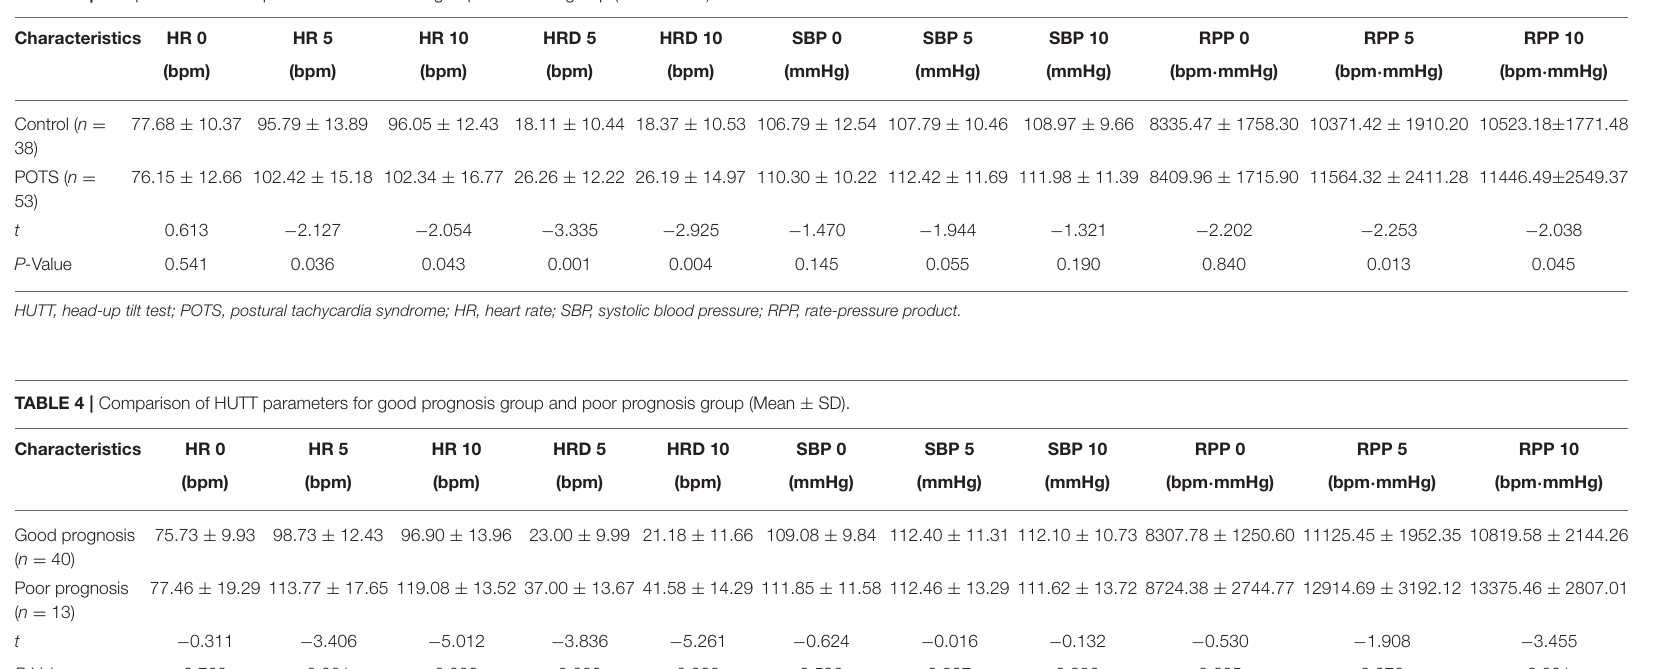
HUTT, head-up tilt test; POTS, postural tachycardia syndrome; HR, heart rate; SBP, systolic blood pressure; RPP, rate-pressure